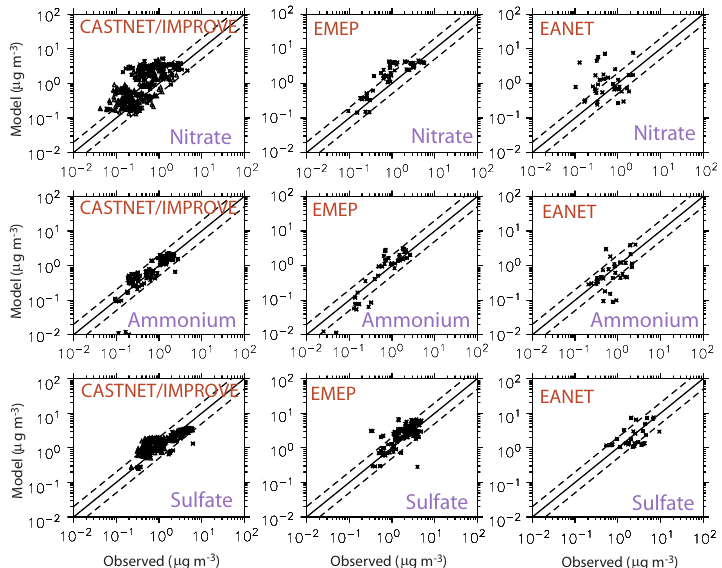
Fig. 12. Observed and modelled (with ISORROPIA-II) annual average concentrations (in µgm − 3 ) for the year 2001 of nitrate (top row), ammonium (middle) and sulfate (lowest row) compared to observational data. Left column: CASTNET (star) and IMPROVE (triangle); middle column: EMEP; right column: EANET. Dashed lines indicate the 1:2 and 2:1 ratios. Table 6. Summary of the comparison of model data to observations taken from the EMEP (Europe), CASTNET (North America) and EANET (Asia) networks (simulations performed using ISORROPIA-II and EQSAM3 are shown). AMR is the arithmetic mean of the modelled values/the arithmetic mean of the observed values; GMR is the geometric mean of the modelled values/the geometric mean of the observed values; PF2=Percentage of modelled points within a factor of two of the